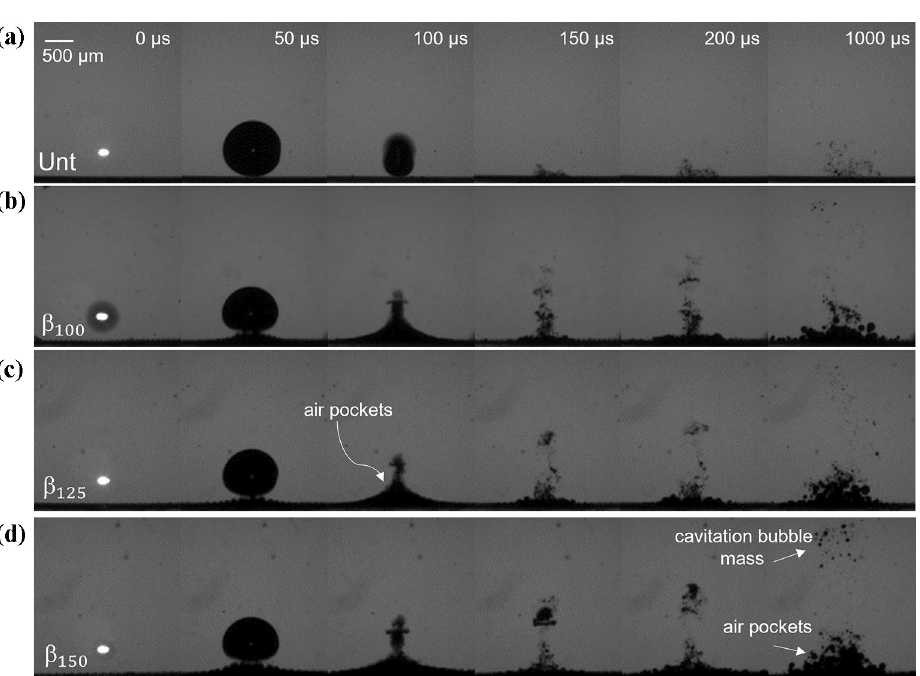
Figure 4. Comparison of a single cavitation bubble collapsing at a stand-off distance of γ = 1 from ( a ) untreated PDMS, ( b ) β 100 , ( c ) β 125 , and ( d ) β 150 microstructures. The black line at the bottom of each image corresponds to the sample